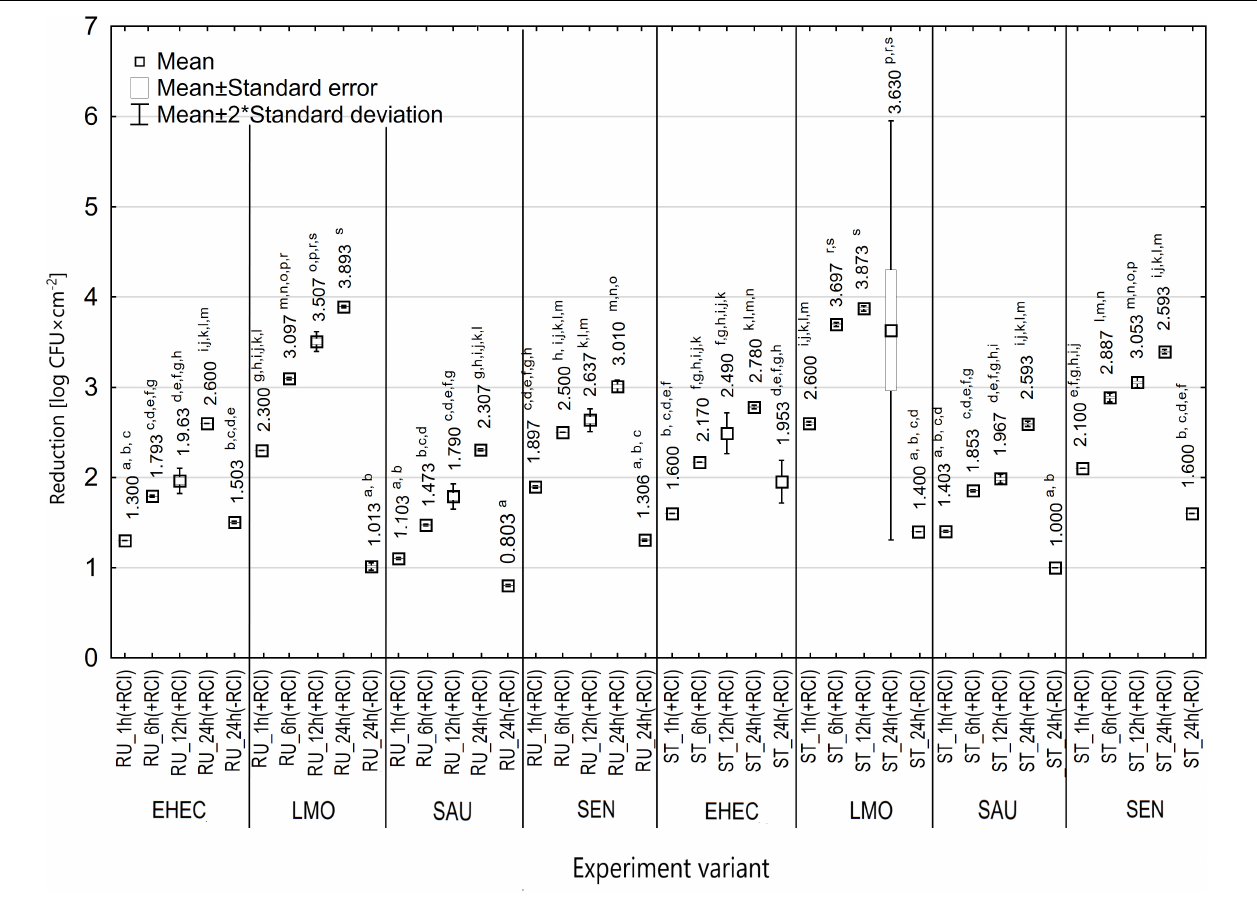
FIGURE 6 | Reduction in the number of bacteria under the influence of RCI depending on the exposure time [RU – rubber, ST – stainless steel; a, b, c – values marked with different letters are significantly different ( P < 0.05); EHEC – E. coli O157:H7; LMO – L. monocytogenes ; SAU – S. aureus ; SEN – S . Enteritidis].